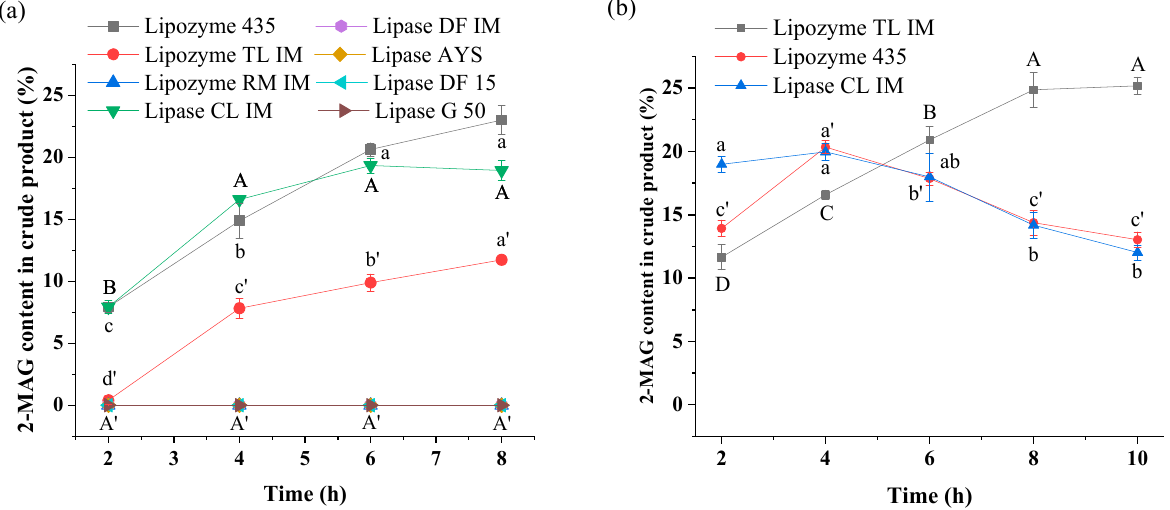
Figure 1. Effects of lipase type on the content of 2-MAG in the crude product with 8% ( a ) and 15% lipase load ( b ). Reaction conditions: ( a ) molar ratio of 1:40 (fungal oil/ethanol), lipase load of 8% (relative to the mass of oil), a w of 0.53, 35 °C; ( b ) molar ratio of 1:40 (fungal oil /ethanol), lipase load of 15% (relative to the mass of oil), a w of 0.53, 35 °C. Different letters in the figure indicated significant differences at the p < 0.05 level.